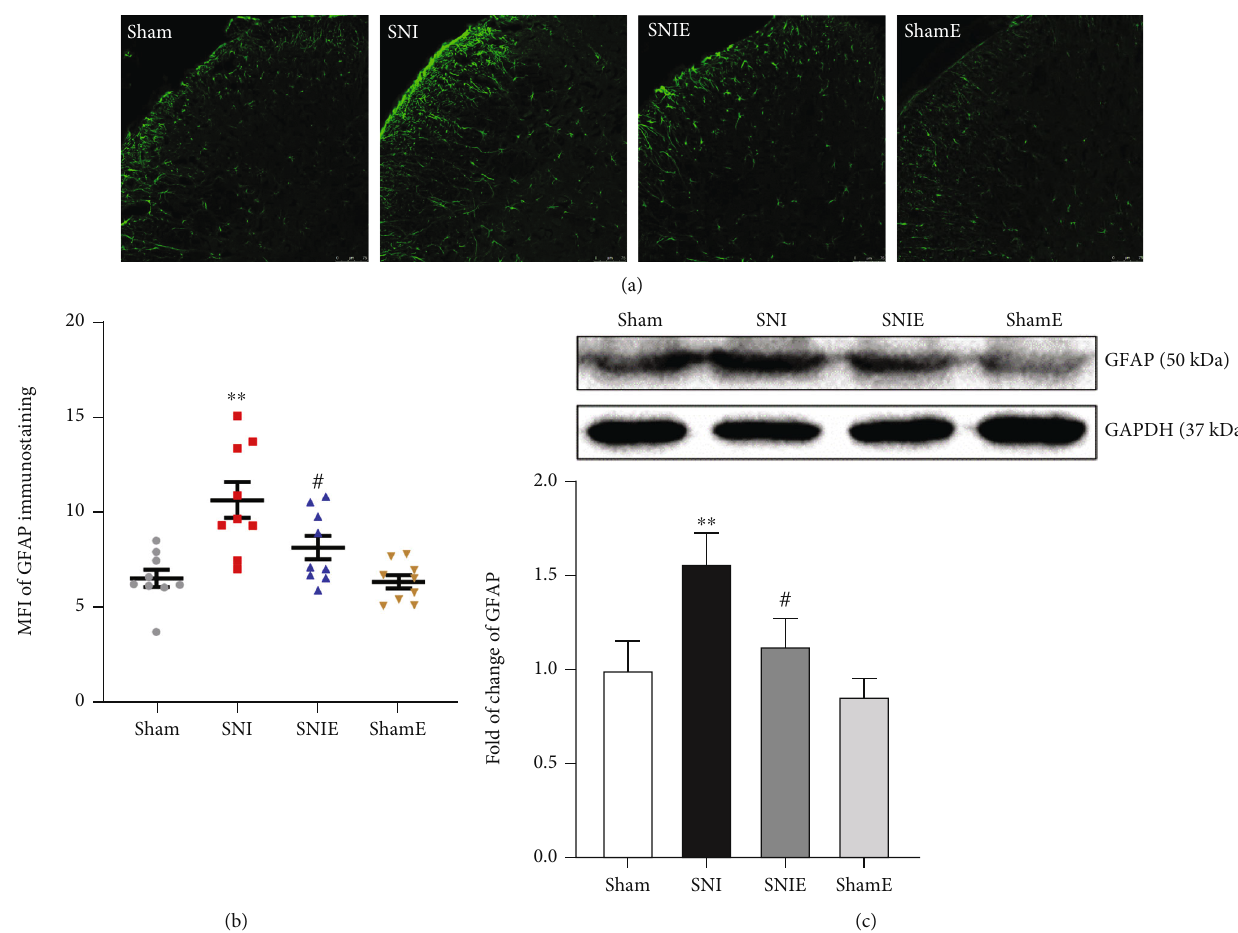
Figure 4: Astrocytes in the spinal cord are activated in mice 24 days after SNI. (a) Representative images of MFI for GFAP in the spinal dorsal horn. (b) Quanti fi cation of GFAP in the spinal dorsal horn ( scar bar = 75 μ m, n = 9 spinal slices from three mice for each group). (c) Western blotting analysis for the expression changes of GFAP ( n = 6 ). Values represent the mean ± SEM . ∗∗ P < 0 : 01 versus the sham group; # P < 0 : 05 versus the SNI